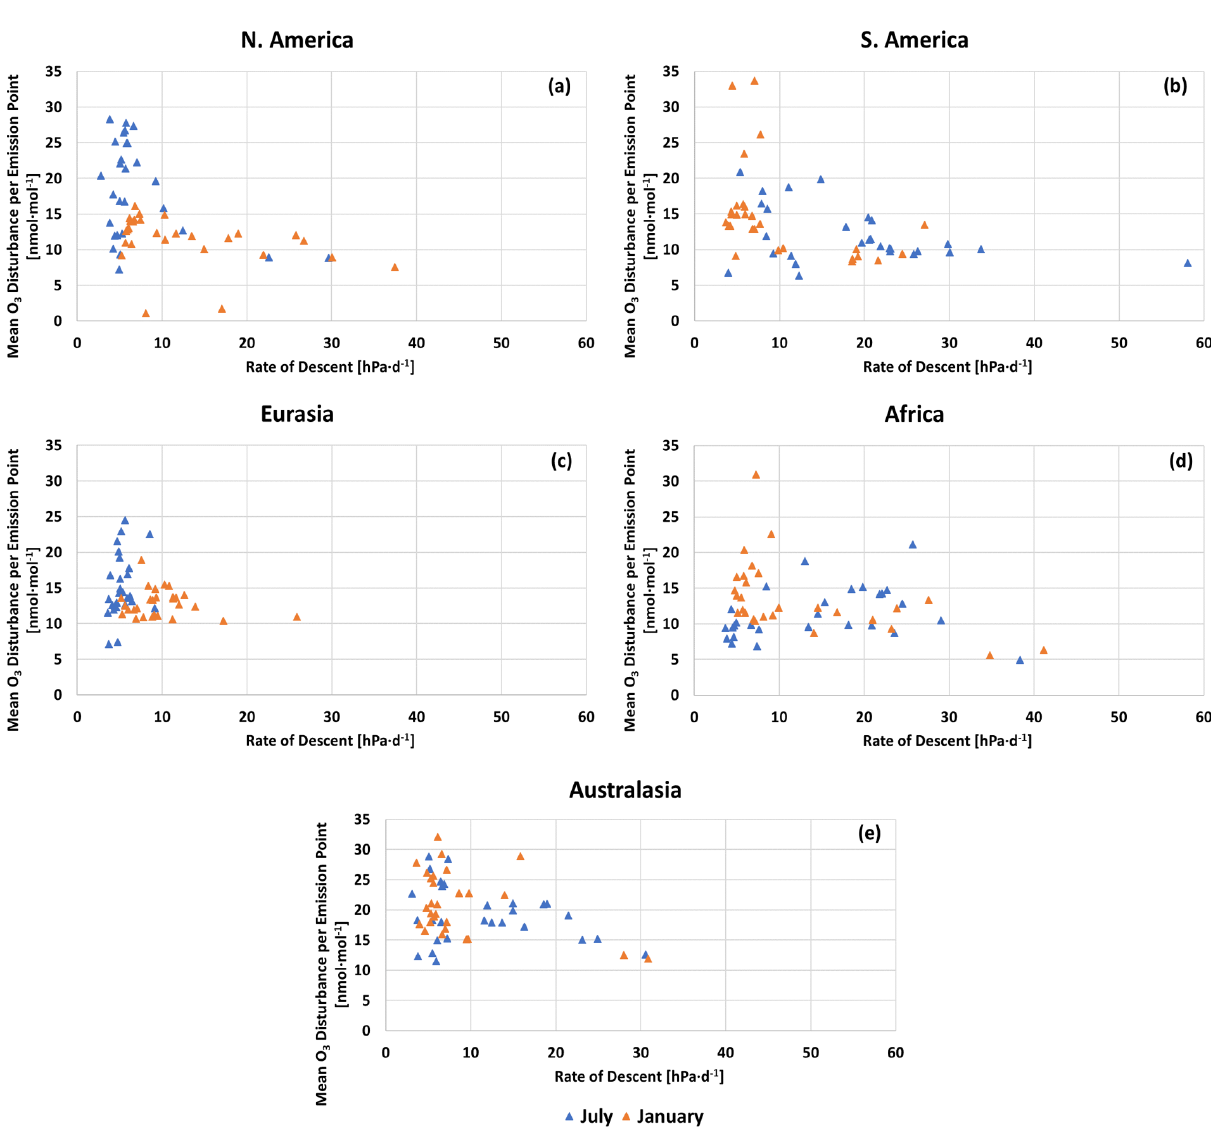
Figure 6. Variation of the 90d rate of descent ˙ H with the mean O 3 disturbance for each of the 28 median NO x -carrying Lagrangian air parcel trajectories for January (orange) and July (blue) for each